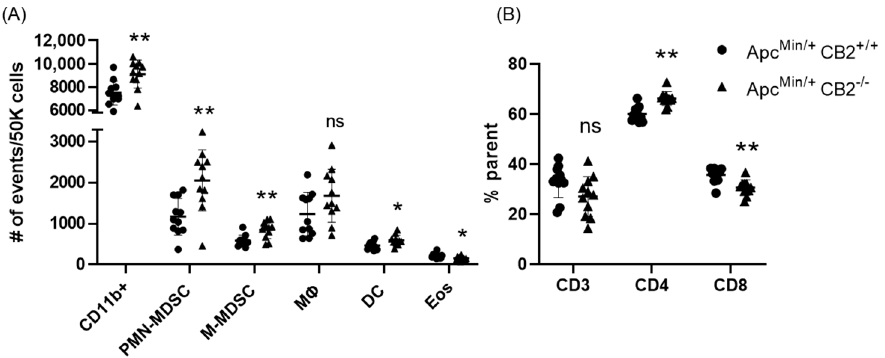
Figure 6. The CB2 receptor alters the balance between pro-tumor and anti-tumor cells in the spleen and tumor microenvironment of Apc Min/+ mice. ( A ) Relative frequency of CD11b+, CD11b+Ly6G hi Ly6C int (PMN-MDSC), CD11b+Ly6G-Ly6C hi (M-MDSC), CD11b+F480+ (macrophage, M Φ ), CD11b hi Cd11c hi (Dendritic cell, DC). The values are expressed as the number of events per 50,000 cells. ( B ) CD3+, CD3+CD4+, and CD3+CD8+ T cells in the spleen. CD3 expressed as the percent of single cells; CD4 and CD8 expressed as the percent of CD3 cells. Apc Min/+ CB2 +/+ , n = 11 (5 females and 6 males); Apc Min/+ CB2 − / − , n = 11 (5 females and 6 males). Student’s t -test, * p < 0.05 and ** p < 0.01; ns: not